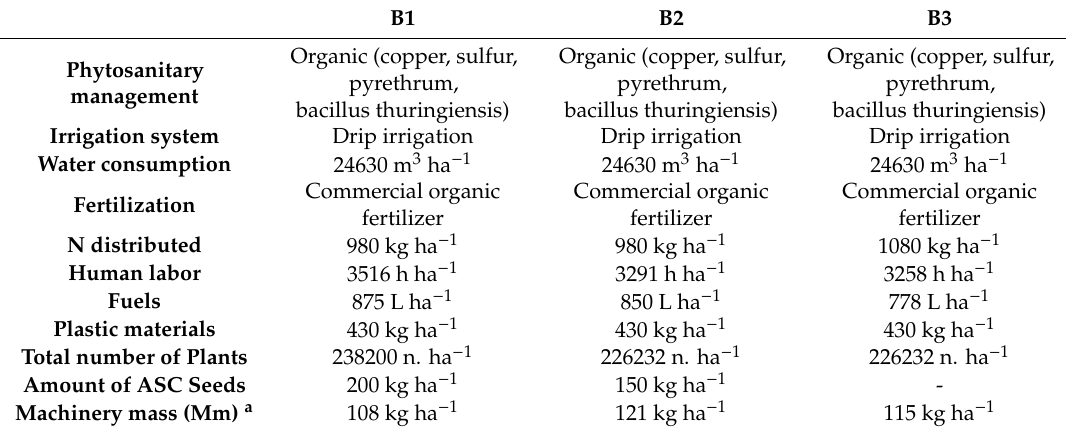
Table 1. Total inputs of the three cropping systems carried out in the four-year experiment. B1 B2 B3 Phytosanitary